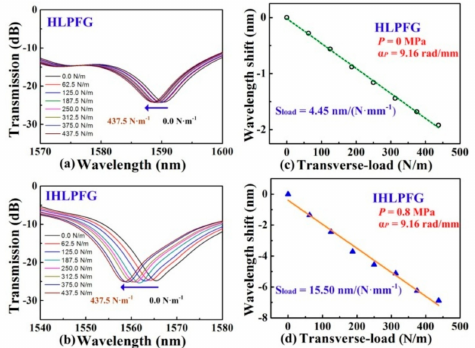
Figure 35. Transmission spectrum evolution of the ( a ) HLPFG and ( b ) I-HLPFG in PCF with air-hole diameters of 2.9 and 3.6 µ m, respectively; measured resonant wavelength shift of the ( c ) HLPFG and ( d ) I-HLPFG as a function of the transverse load